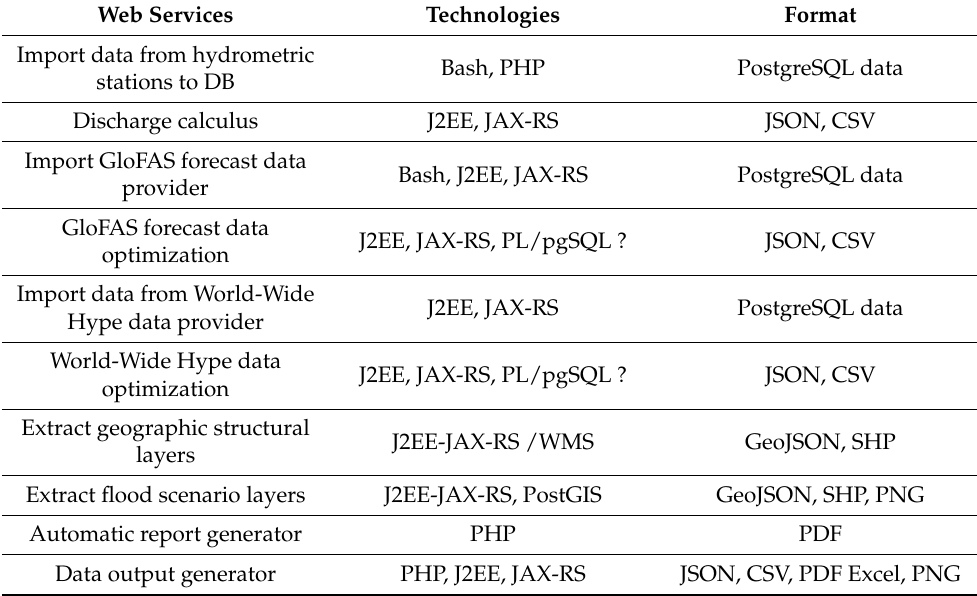
Table 3. Web services implemented in the SLAPIS web